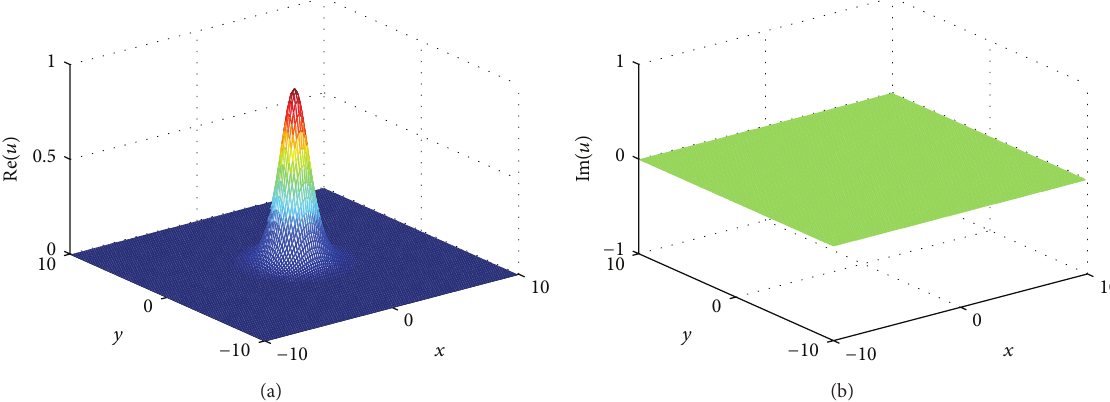
Figure 11: Lattice soliton profile corresponding to the first renormalization factor on the Penrose potential, all with 𝑉 0 = 3.5 , 𝐾 = 1 , and 𝜇 = 1.5 for the self-focusing quintic model. (a) Real part of the lattice soliton. (b) Imaginary part of the lattice